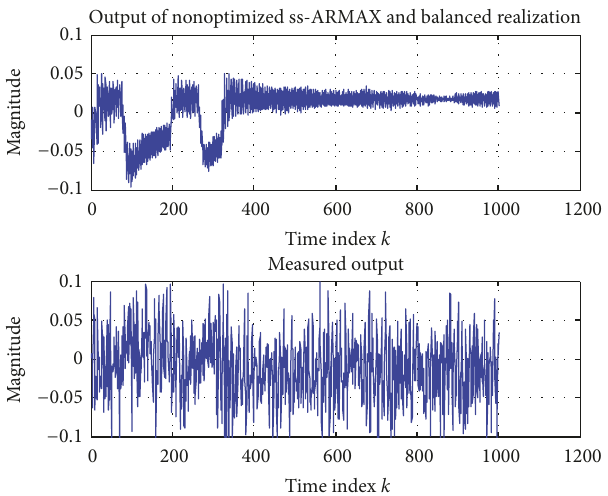
Figure 15: Cost during TS